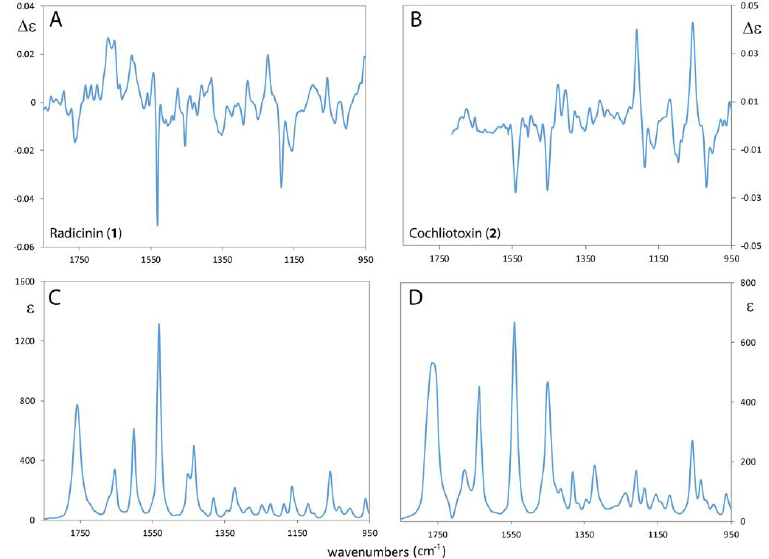
Figure 2. Experimental Vibrational Circular Dichroism (VCD) and IR spectra of radicinin ( 1 ) (panels A , C ) respectively and of cochliotoxin ( 2 ) (panels B , D ) in CDCl 3 solution. (See Figure S1 of Supplementary Material for the VCD noise level). Molecules 2019 , 24 , x FOR PEER REVIEW